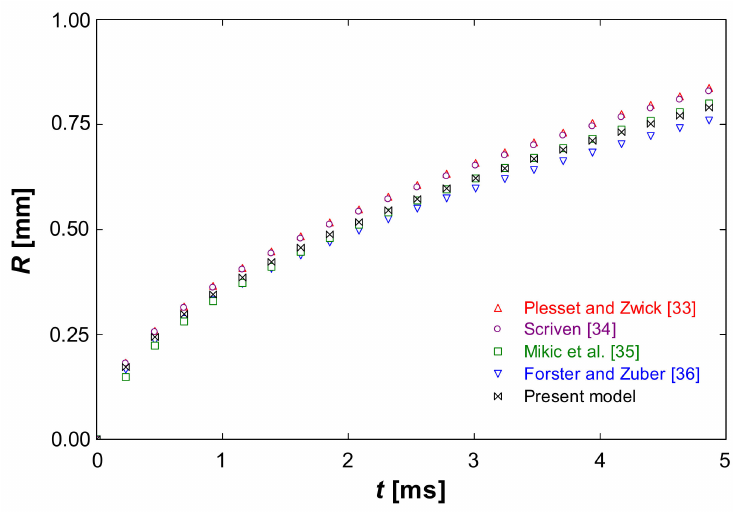
Figure 3. Bubble radius (R) against time (t) applied to a spherical water bubble growing in a 5 ◦ C superheated liquid